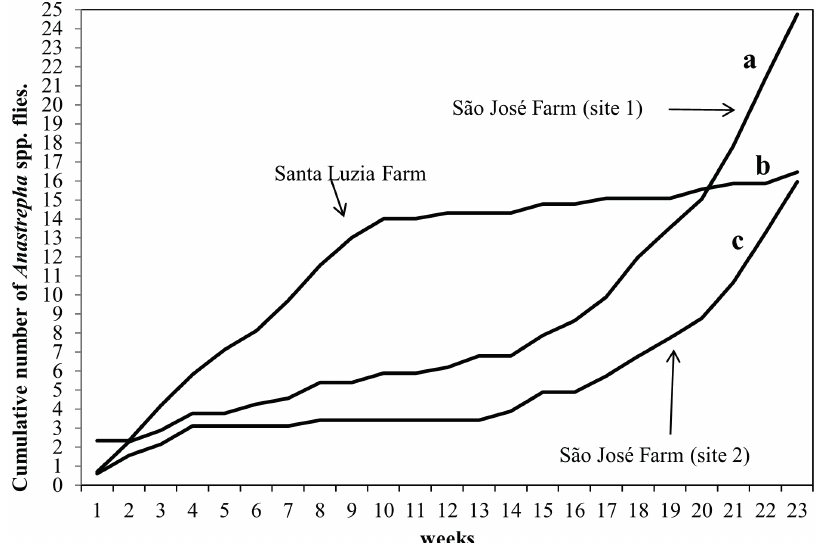
Figure 2 - Population fluctuation of fruit flies in three guava orchards (cultivar Novo Milênio) between August 2013 and January 2014 (Ivinhema, State of Mato Grosso do Sul, Brazil). Multiple comparisons were made by Dunn-Bonferroni bilateral test (p <0.01), where the same letters indicate non-significant